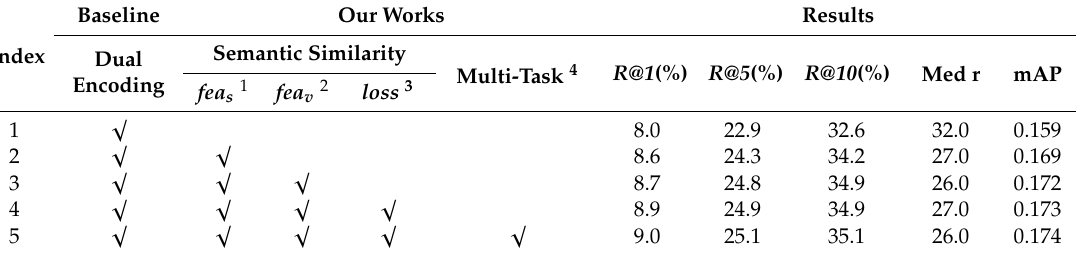
Table 3. Ablation study on the MSR-Video to Text (MSR-VTT) dataset.